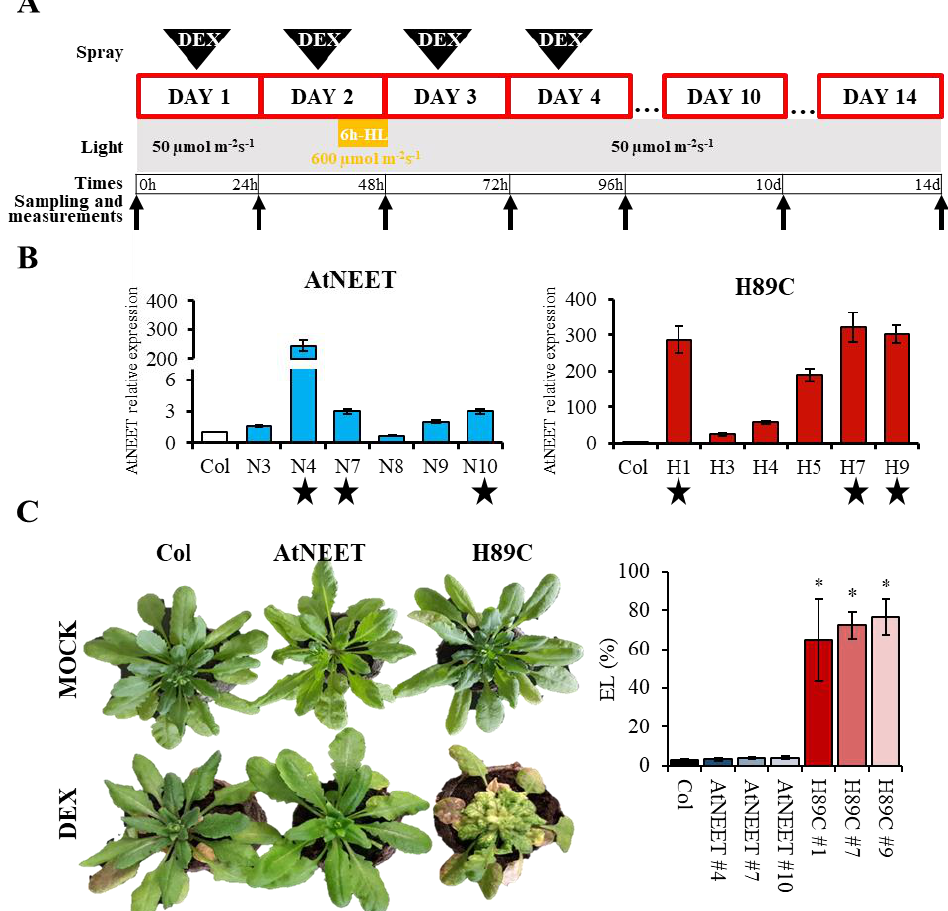
Figure 1. The experimental system used to study the function of AtNEET in Arabidopsis. ( A ) Outline of the time-course design. Triangular arrows at the top indicate the application of DEX to plants (Col, AtNEET, and H89C), and black arrows on bottom indicate the sampling times of all plants for analysis. Yellow box indicates the light stress treatment that was applied on day 2. Please see text for more information. ( B ) Steady-state transcript expression levels of AtNEET in Col and homozygous AtNEET and H89C plants following 4 doses of DEX application. Stars indicate the plants chosen for further analysis. ( C ) Representative images of mock and DEX treated Col, AtNEET, and H89C plants on day 14 are shown alongside ion leakage from leaves of the selected lines, also measured on day 14. All experiments were repeated at least three times with similar results. Asterisks denote statistical significance with respect to control (Col) at p < 0.05 (Student t -test, SD, n = 5). Abbreviations used: DEX, dexamethasone; EL, electrolyte leakage; HL, high light.